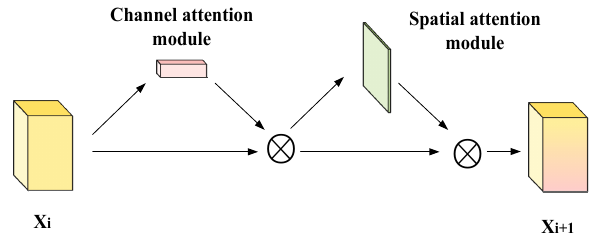
Figure 3. Architecture of the proposed attention module. Table 1. Parameter of the convolution layer.